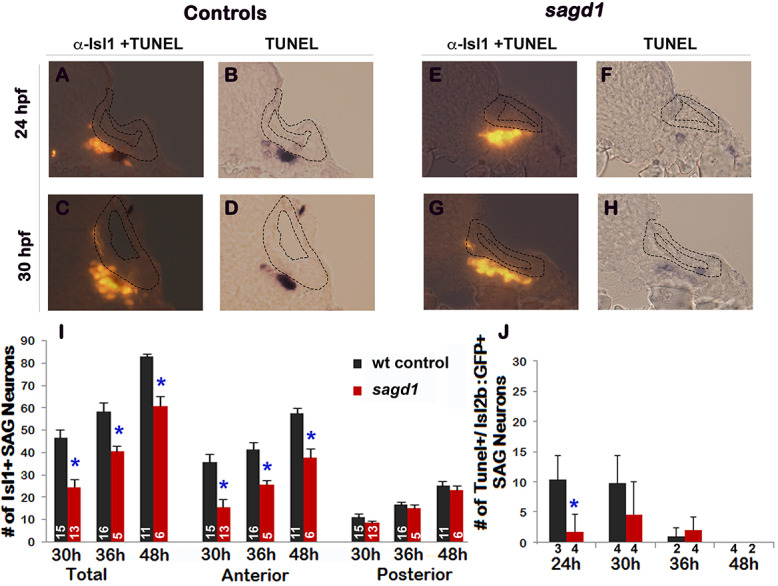
Quantitation of mature Isl1/2+ SAG neurons and TUNEL in sagd1 mutants.(A–H) Cross sections (dorsal up, medial to the right) through the anterior/vestibular portion of the otic vesicle in control embryos (A–D) and sagd1 mutants (E–H) showing anti-Isl1/2 stained SAG neurons (A,C, E, G) and co-staining for TUNEL (B, D, F, H). (I) Number of Isl1/2+ SAG neurons at 30 hpf counted from whole mount preparations. Anterior/vestibular SAG neurons are under-produced in sagd1 mutants, whereas posterior/auditory neurons develop normally. (J) Number of TUNEL+ apoptotic cells at the indicated times. sagd1 mutants show fewer apoptotic cells than normal at 24 and 30 hpf, indicating that the deficiency in vestibular SAG neurons is not due to cell death. Sample sizes are indicated (I, J).